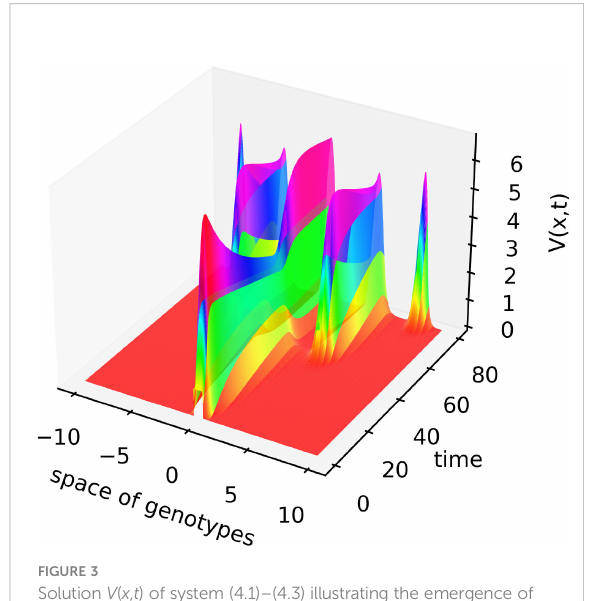
FIGURE 3 Solution V ( x , t ) of system (4.1) – (4.3) illustrating the emergence of new virus variants for the values of parameters are as follows: L = 10, D = 0 : 005, k = 0 : 5, a = 1, b = 2, s 0 2 = 50 : 0, s 1 2 = 80, s 0 3 = 1, s 1 3 = 8, s 4 = 4, the half-support of the kernel (4.10) N =1